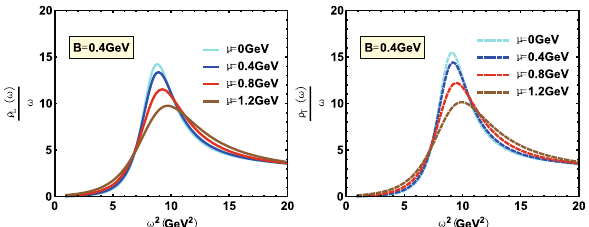
Fig. 3 The spectral function of the J /(cid:2) state with different chemical potential μ at T = 0 . 3GeV.Theleftpictureisformagneticfieldparallel to polarization and the right one is for magnetic field perpendicular to polarization